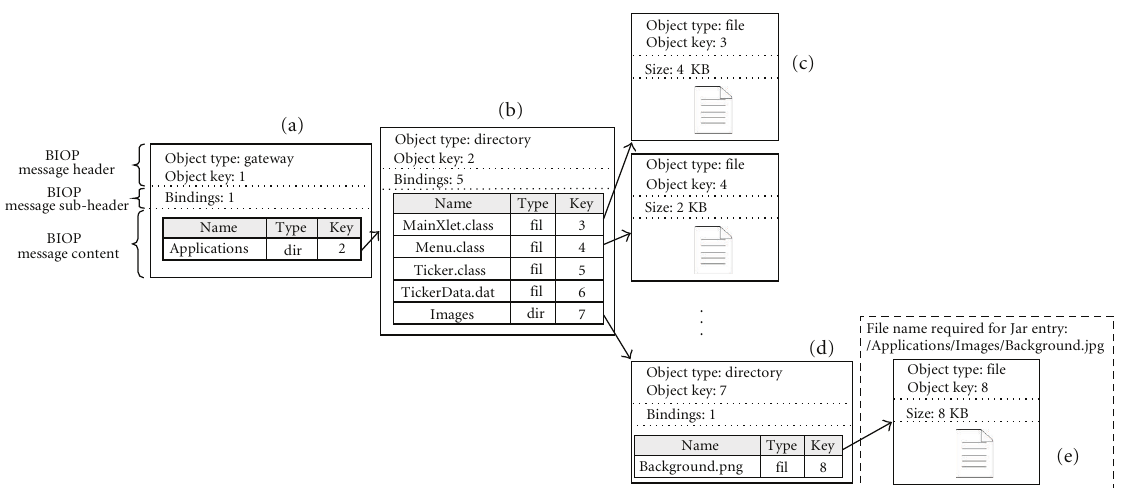
Figure 12: Organization of the example BIOP objects.